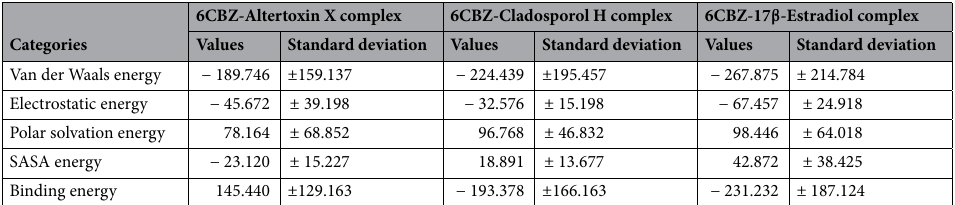
Table 2. Binding free energy calculations of 6CBZ target protein complexes with Altertoxin X, Cladosporol H, and 17 β -Estradiol (all results in kJ/mol).